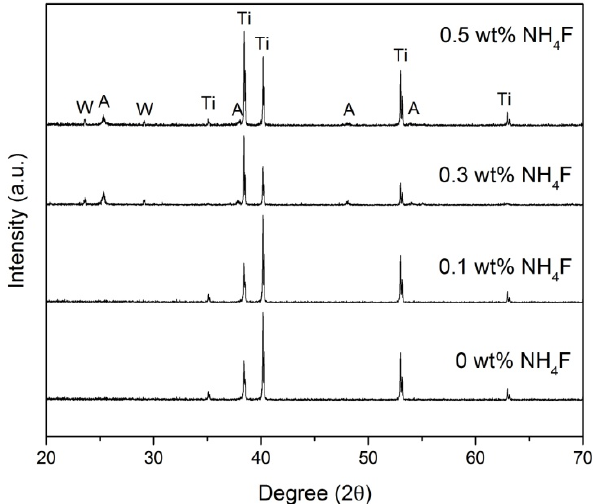
Figure 3. X-ray diffraction patterns of WO 3 -loaded TiO 2 nanotubes produced with different fluoride ion